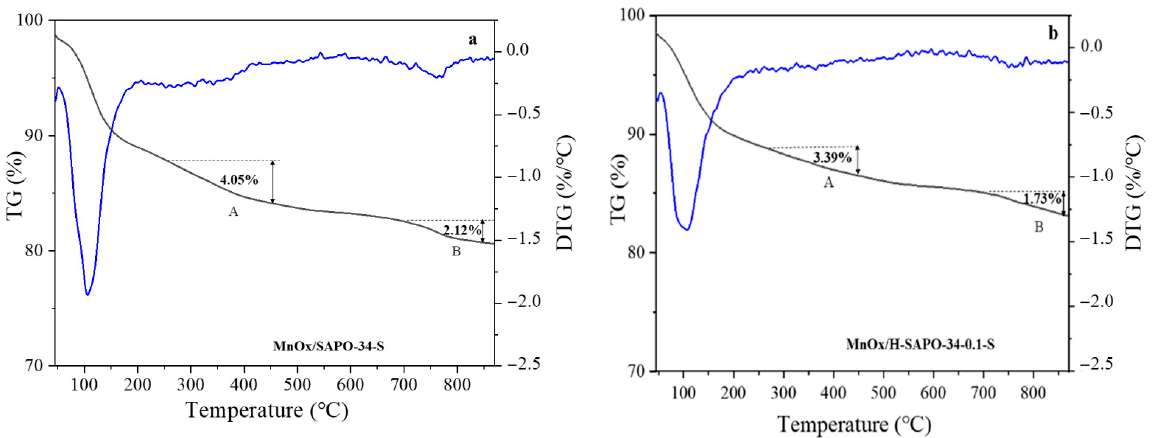
Figure 11. TG-DTG patterns of sulfated MnO x /SAPO-34 ( a ) and MnO x /H-SAPO-34-0.1 ( b ) catalysts .